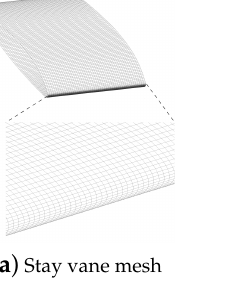
Figure 4. Mesh of the conceptual model.